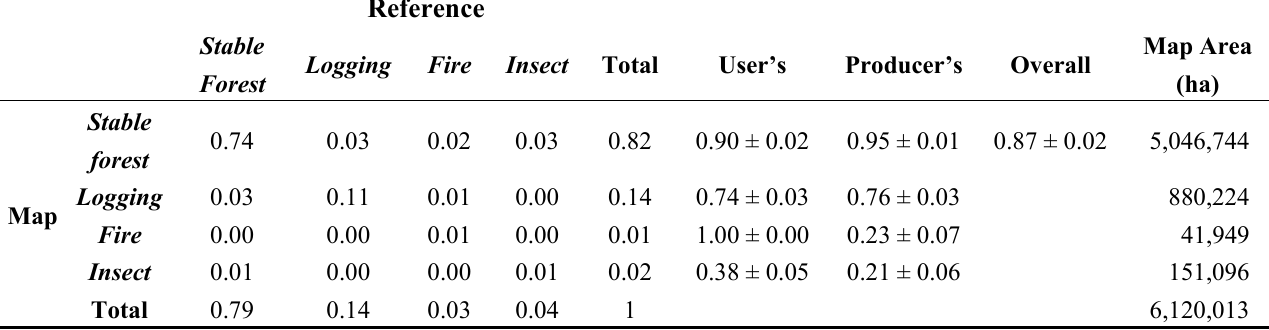
Table 3. Error matrix populated by estimated proportions of area for iteration eight, ensemble threshold for logging ∆DI >−3 , 000, fire ∆NBR >−3 50 and insect outbreak p < 0.05.